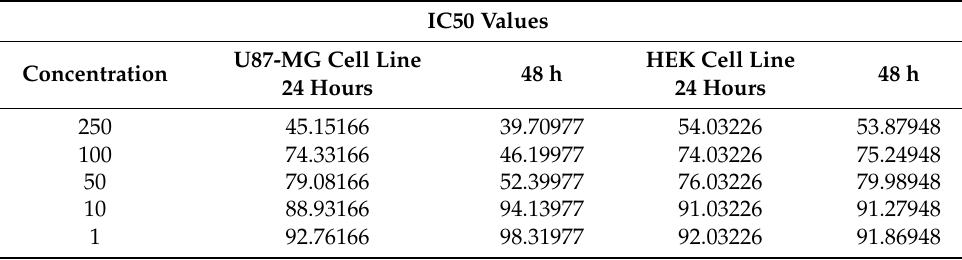
Table 6. Calculated IC50 values of U87-MG and HEK cell lines.